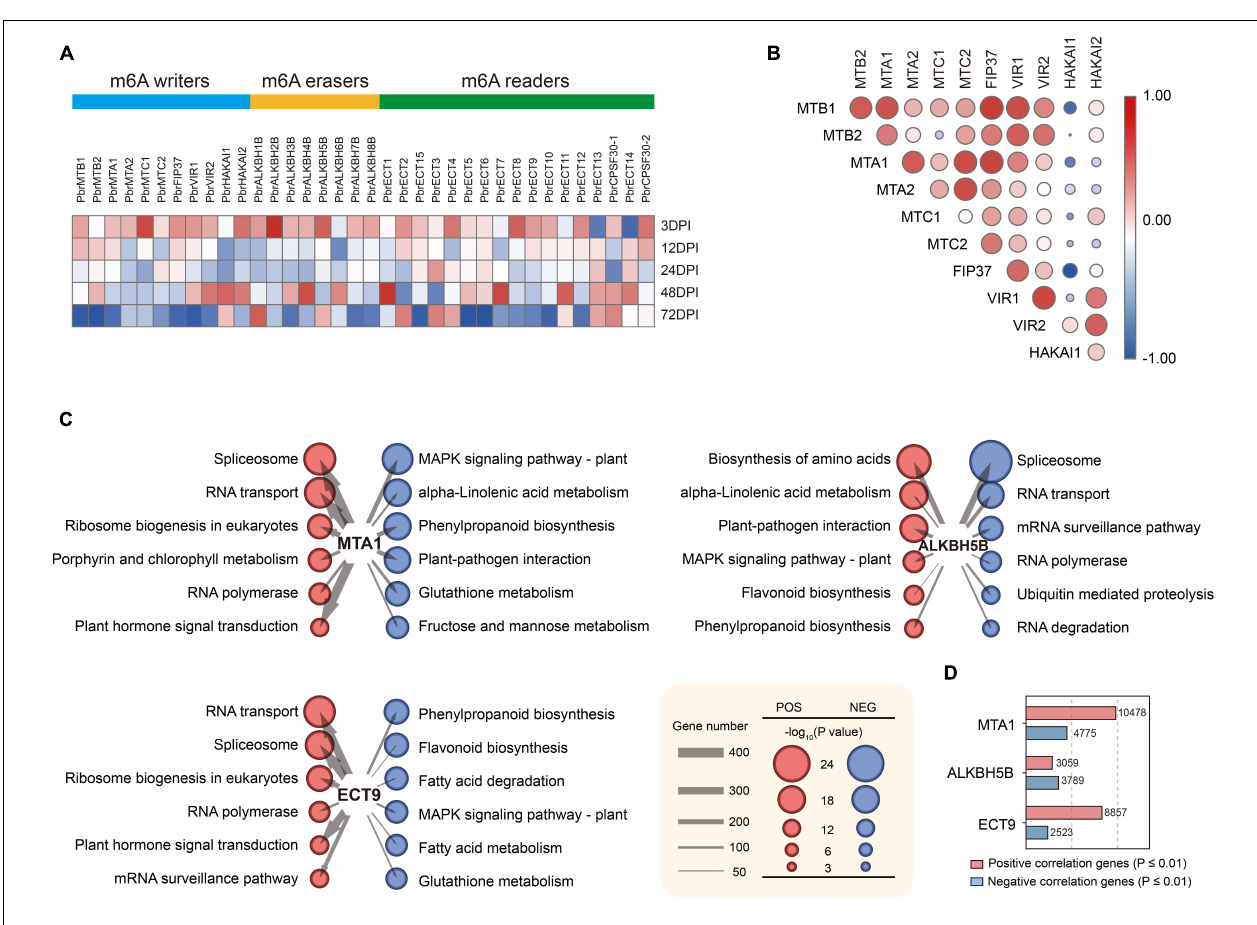
FIGURE 2 | Expression alterations of m 6 A writers, erasers, and readers in pear after fire blight inoculation. (A) Heat map of RNA-Seq expression of m 6 A regulators. Color scale of the dendrogram represents the scale value of TPM, normalized expression data expressed as log2 (TPM+1) values. (B) Correlation among the expression of m 6 A regulators. (C) Network diagram demonstrating the correlation between m 6 A regulators and signaling pathways. Red represents a positive correlation, and blue represents a negative correlation. The size of the nodes corresponds to the number of genes enriched in the entry. The size of the circles corresponds to -log 10 ( p -value) of KEGG pathways. (D) Number of genes that significantly correlated with MTA1, ALKBH5B, and